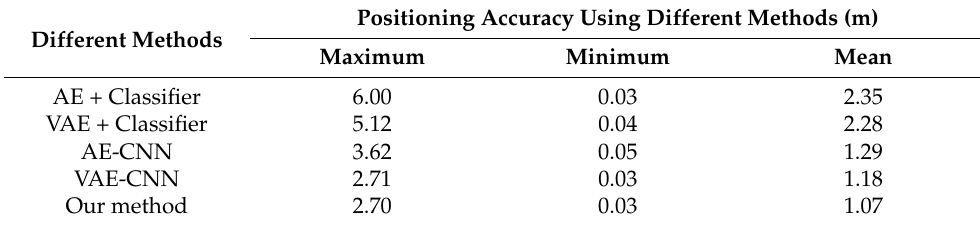
Table 2. Comparison and analysis of positioning performance of various models.